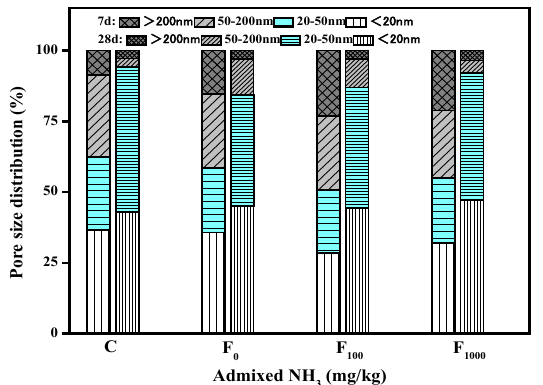
Figure 12. The effect of increasing ammonia content in fly ash on the pore size distribution of the cement paste.